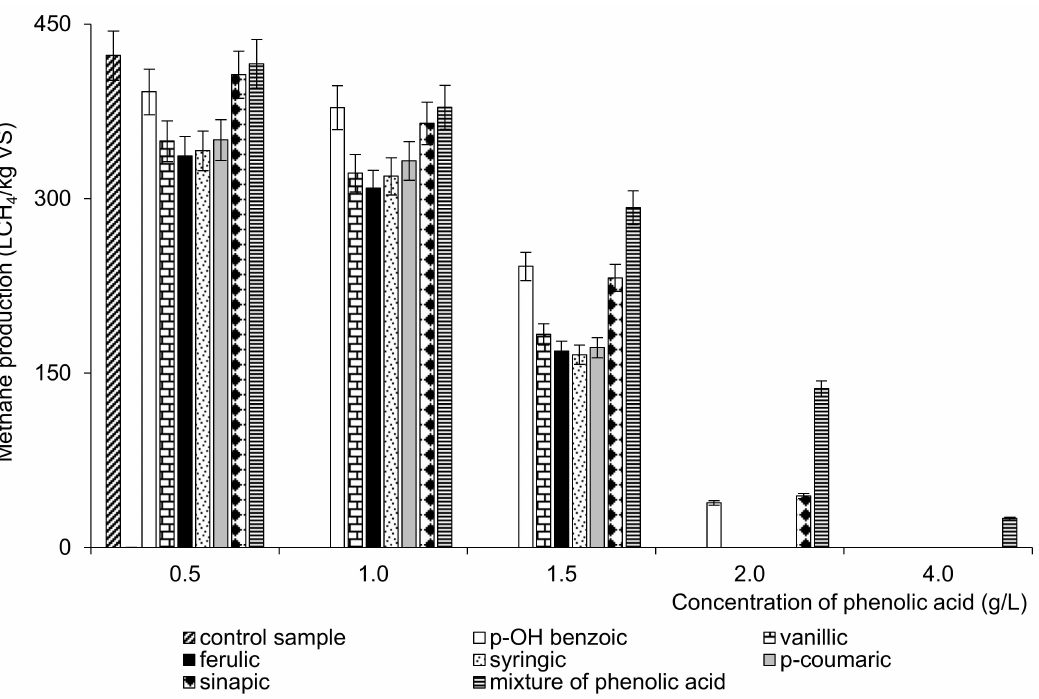
Figure 1. Cumulative methane production at the end of the